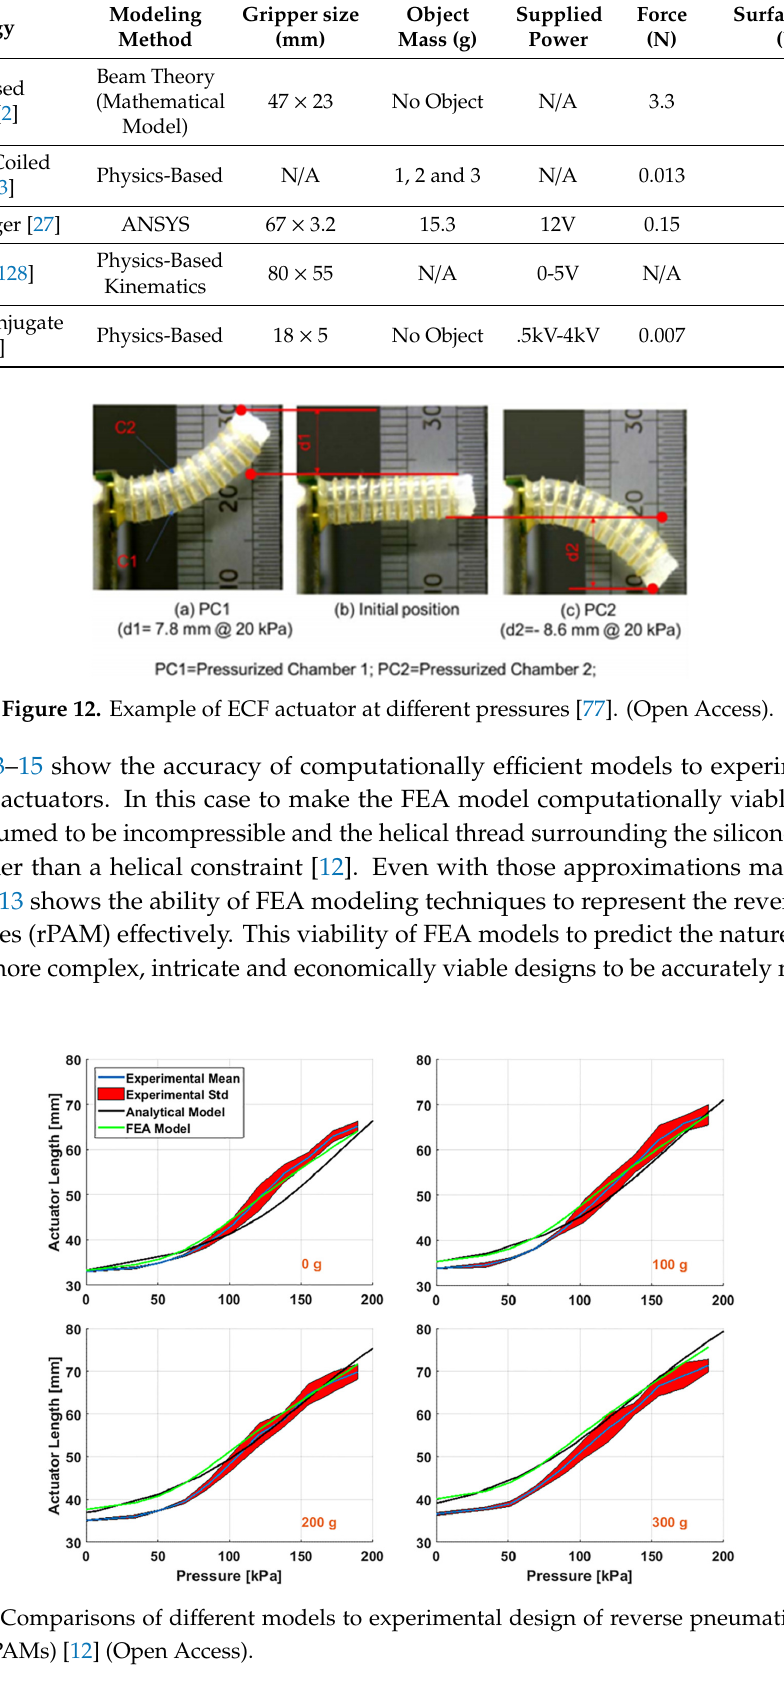
Figure 14. CAD model (Left) compared to prototype of a reverse pneumatic artificial muscle (rPAM) [12] (Open Access).